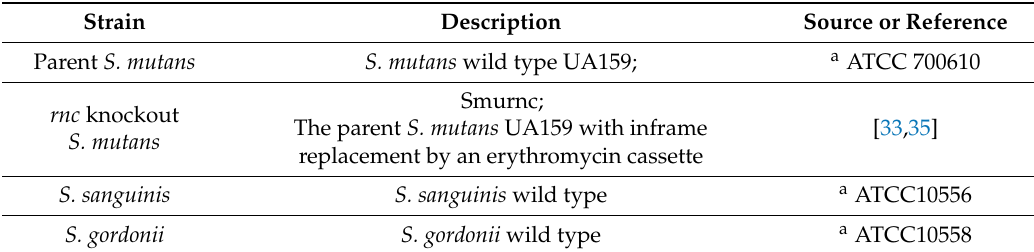
Table 1. Bacterial strains used in this study.